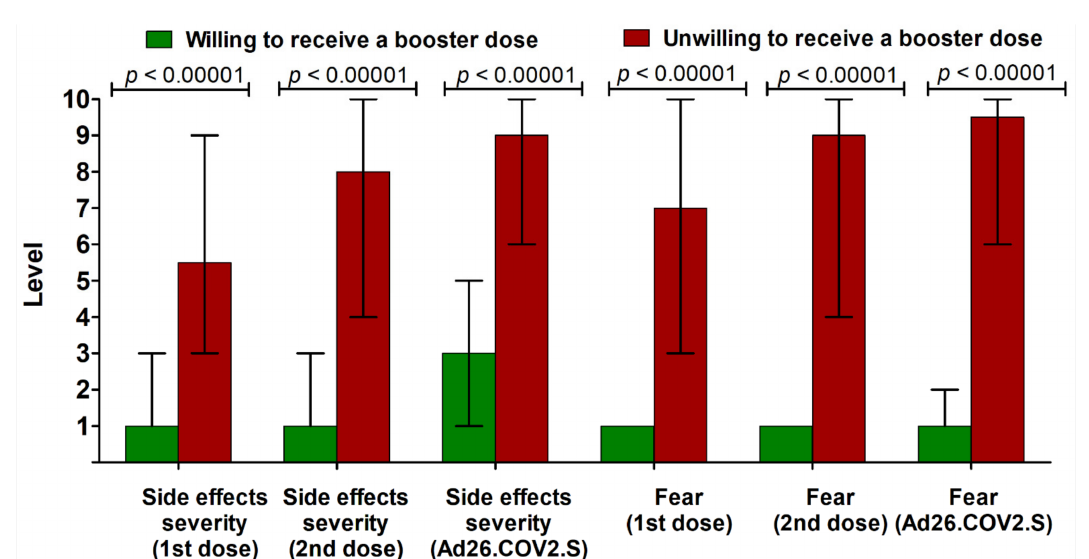
Figure 1. The median (interquartile range) level of side effect severity and associated fear (in 1–10 Likert-like scale) after previously received COVID-19 vaccines in individuals willing and unwilling to receive the potential booster dose ( n = 2322). Subjects who were unsure about receiving a booster dose were excluded from this analysis ( n =